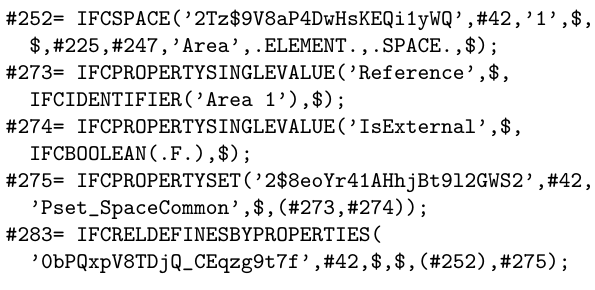
Figure 2. An instance of a BuildingRoom node in the CityGML object graph with some direct